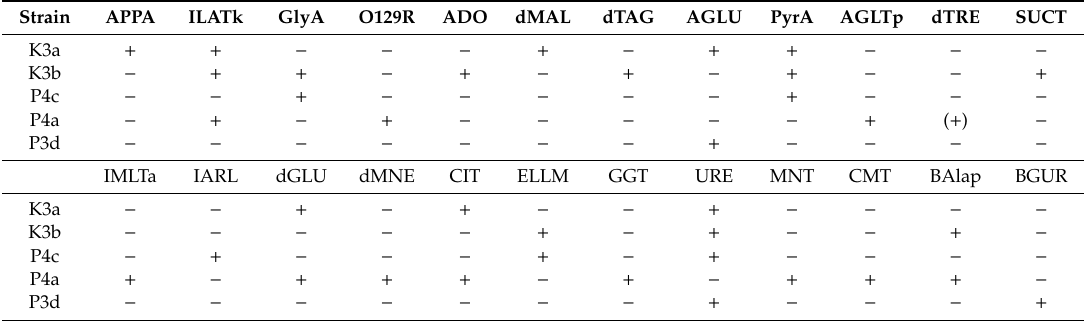
Table 1. The di ff erentiating reactions from Vitek2 ® GN Colorimetric Identification Card (bioMerieux, Warsaw, Poland) for strains coming from the rural WWTP: Sphingomonas paucimobilis (K3a), Ochrobactrum antrophi (K3b) and the municipal wastewater treatment plant (WWTP): Rhizobium radiobacter (P4c), Pseudomonas aeruginosa (P4a), and Sphingobacterium thalpophilum